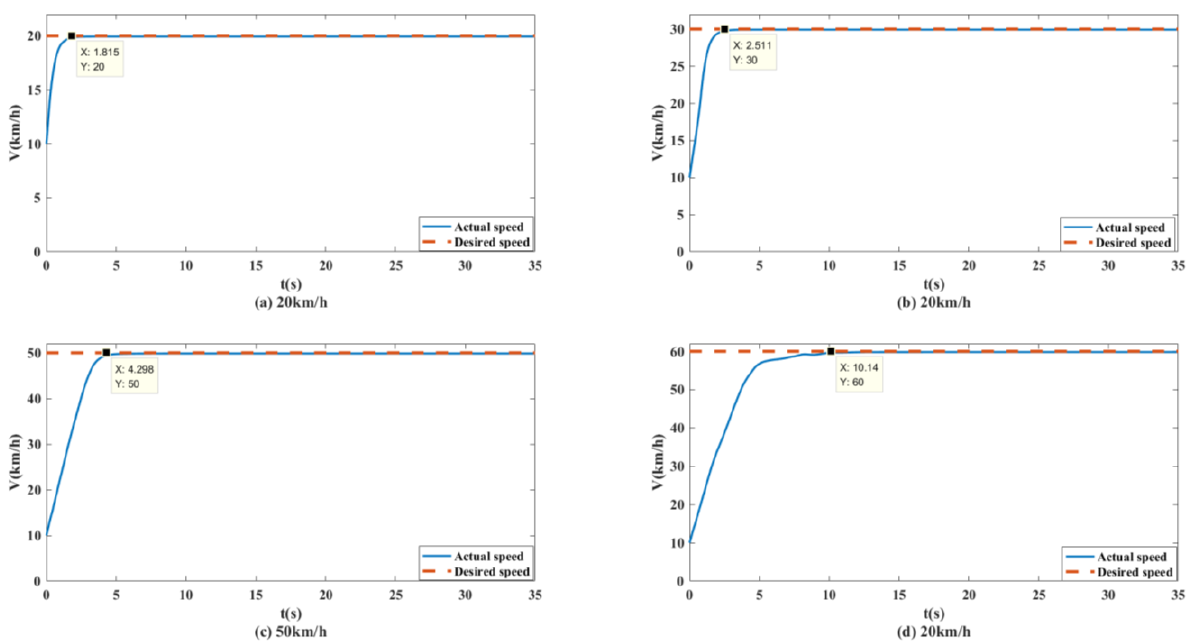
Figure 13. Speed tracking curves of unmanned vehicles at different speeds on the split mu straight road.